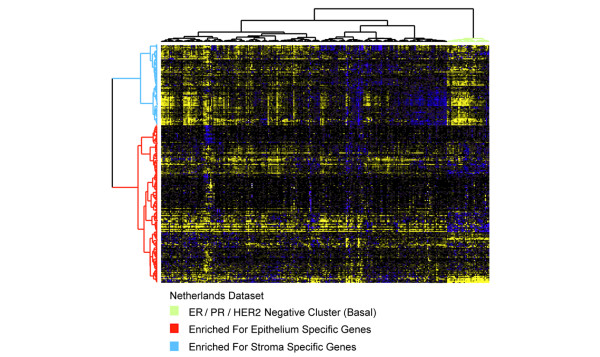
Heatmap of a cancer dataset [8] clustered using the normal gene signature. This signature identifies a distinct cluster of 38 estrogen receptor (ER)/progesterone receptor (PR) negative, HER2 negative samples corresponding to the basal breast cancer subtype [35]. Elevated expression of normal stroma-specific genes appears in a portion of the lumenal and HER2 positive tumors, although this expression does not correlate with the known molecular subtypes of breast cancer.